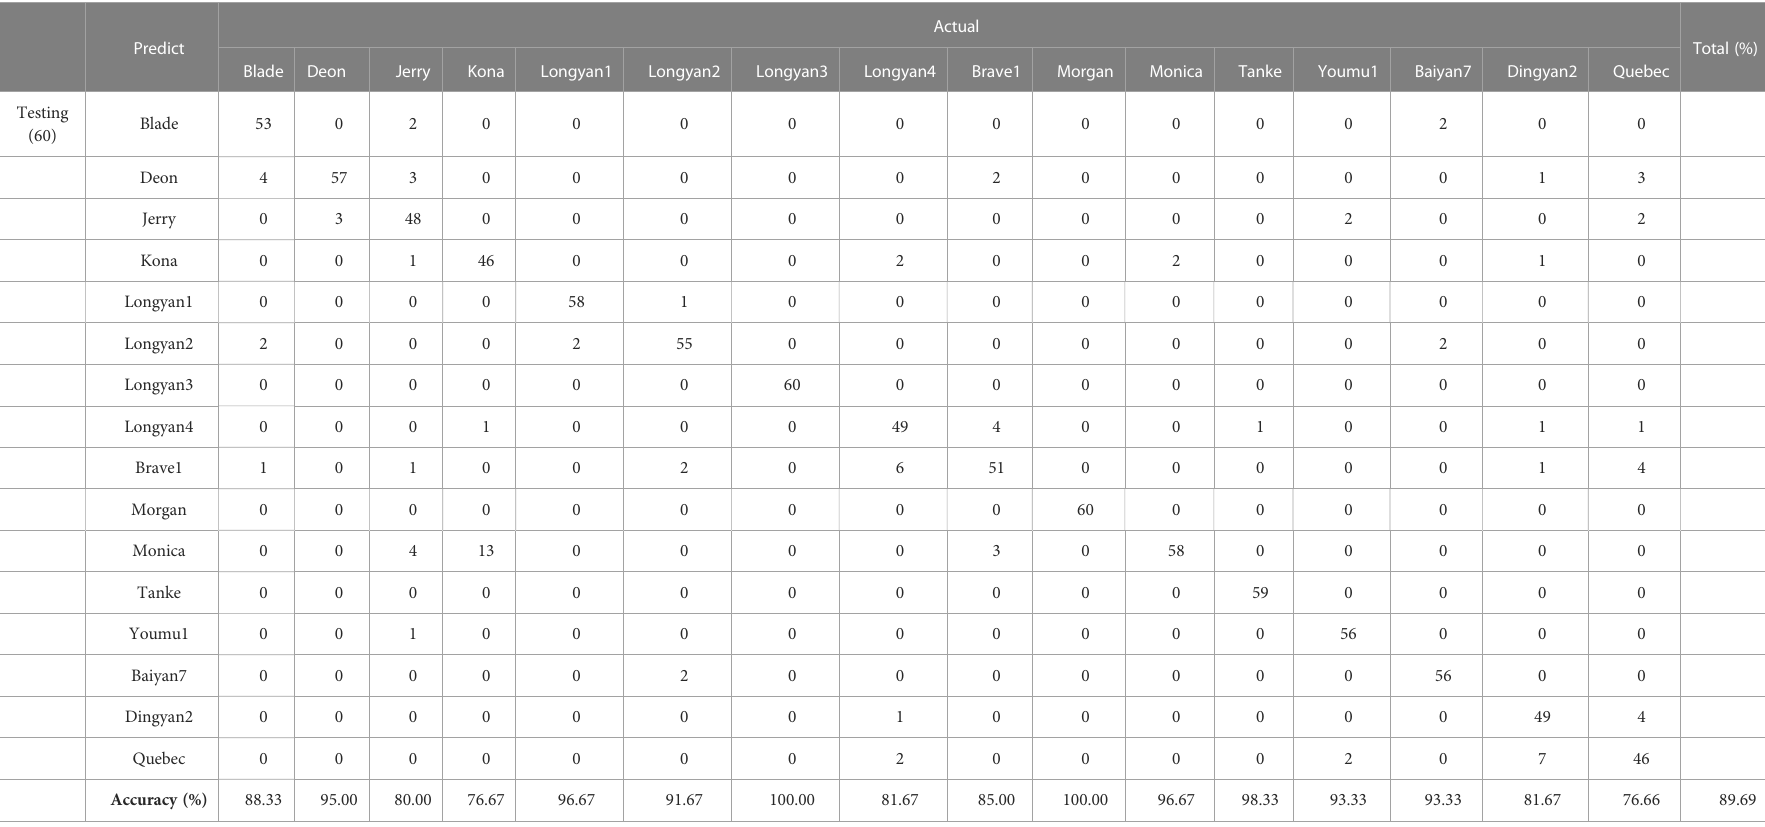
TABLE 1 Discrimination performance based on LDA with morphology and spectral features of 16 Avena sativa L. cultivars.